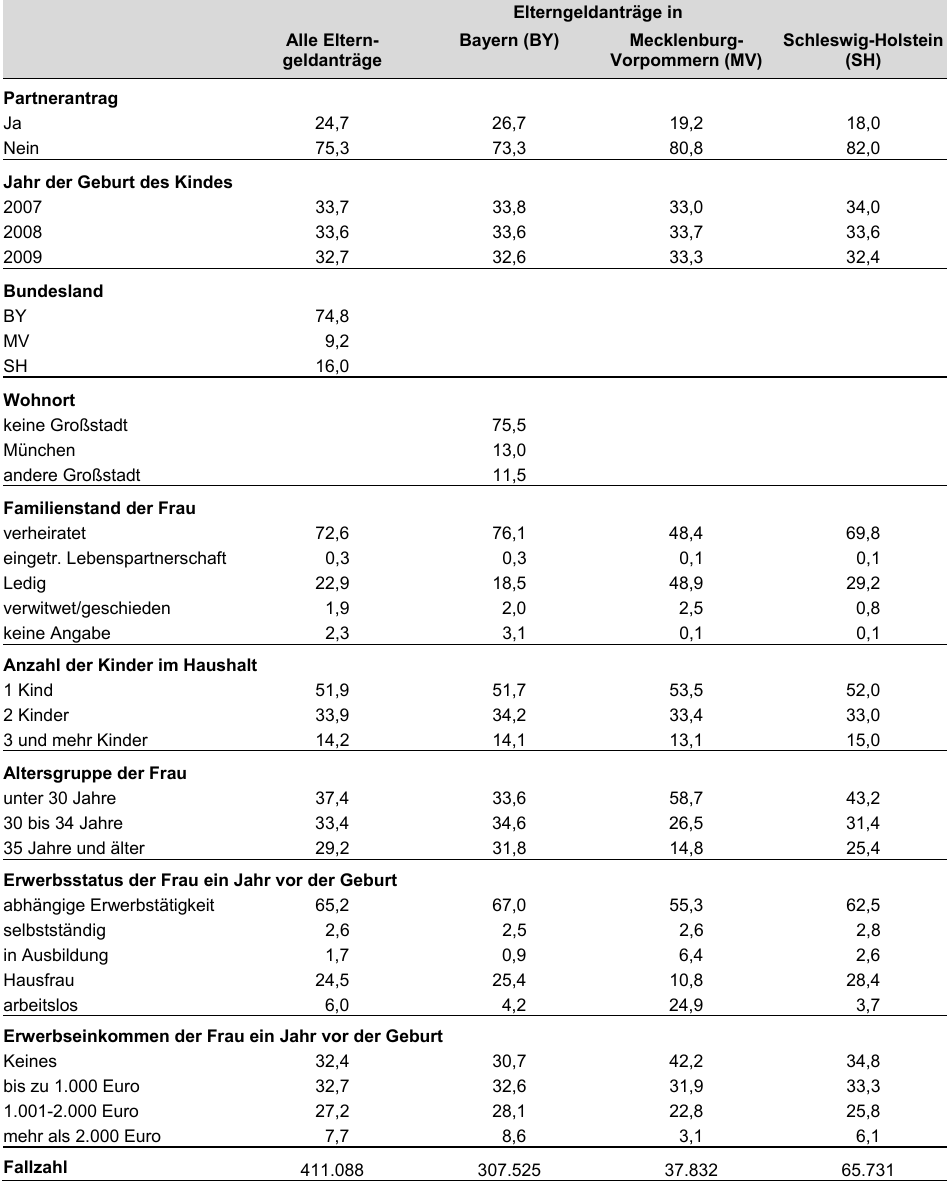
H. Trappe: Väterzeit ‒ das Elterngeld als Beschleuniger der Gleichstellung? 262 Elterngeldanträge